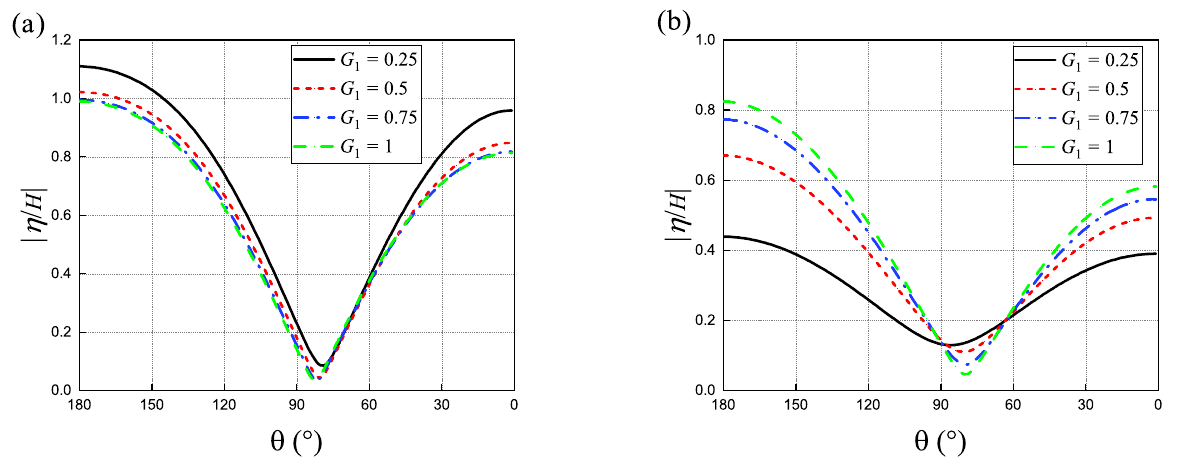
Figure 8. Wave run-up on the outer and inner cylinders versus θ for different wave-porous parameters G with C w = 1, e / a = 1, c / a = 0.5, β = 0, and h / a = 1.5: ( a ) the outer cylinder, ( b ) the inner